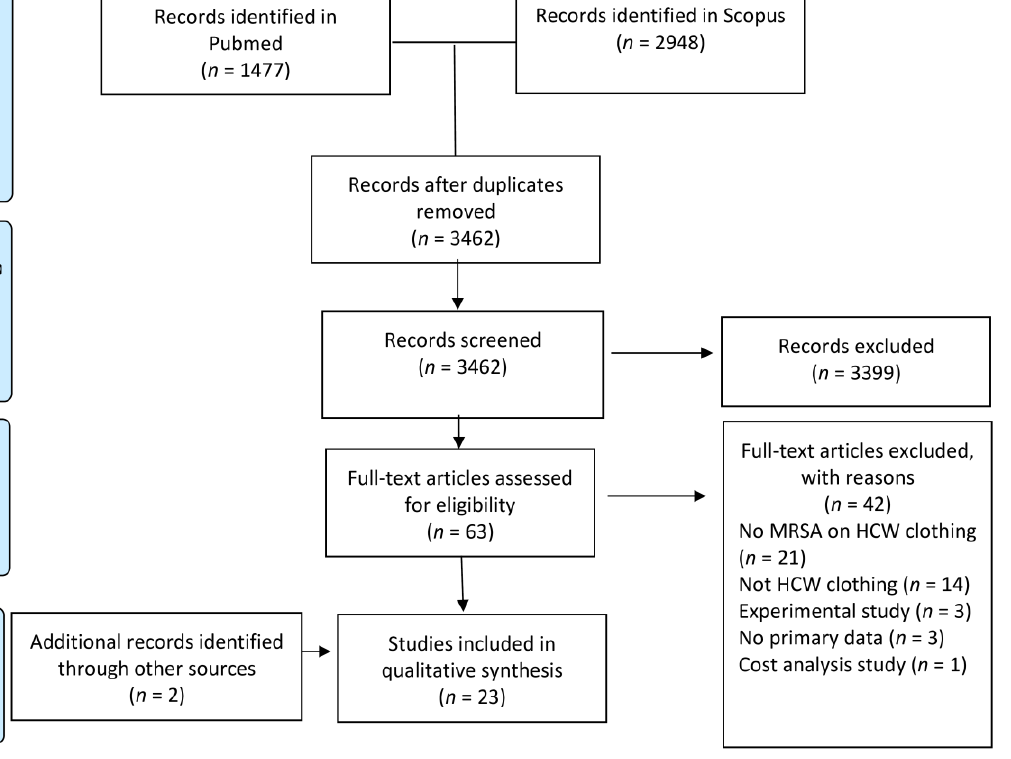
Figure 1. PRISMA flowchart for article screening and study selection.